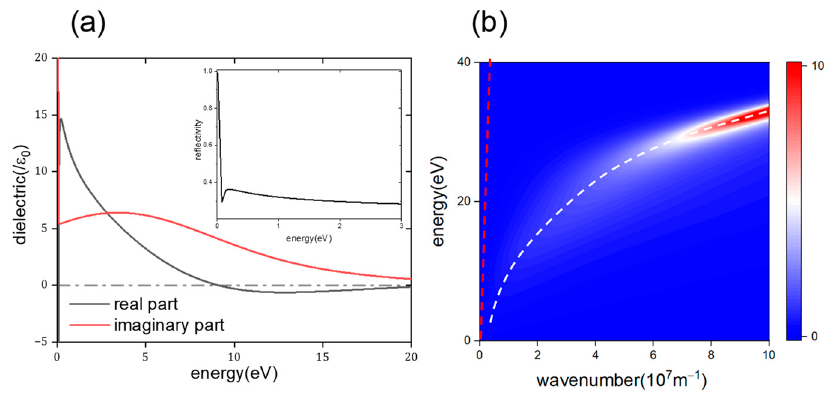
Figure 3. Reflectivity and SPPs dispersion of Ag 2 Te. ( a ) Reflectivity calculated by the dielectric function. ( b ) The loss function of SPPs. The white dashed curve denotes the SPPs dispersion relationship, and the red dashed line denotes the dispersion of light in free space.